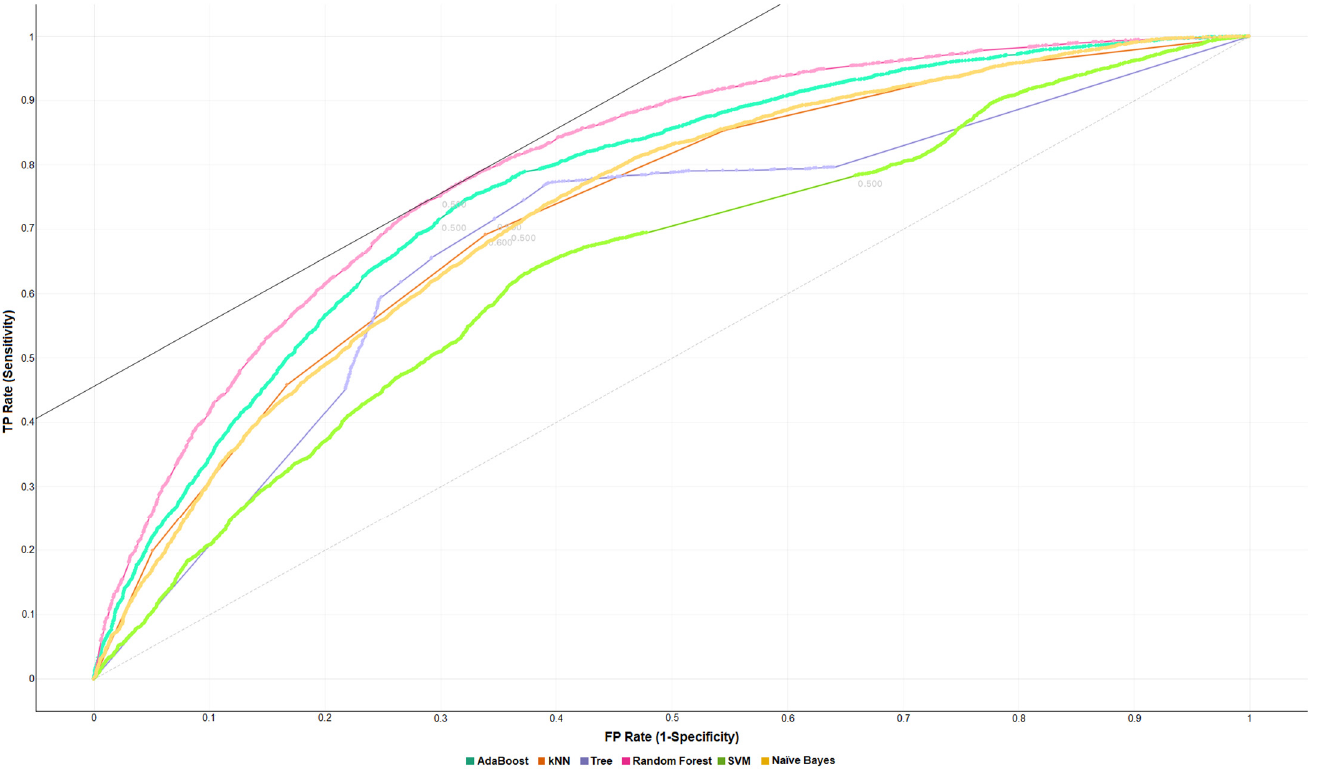
Figure 4. ROC curve for target = 1 with FP = 500, FN = 500, and target probability = 50.0%. The graph shows the ROC curves created by the false positive and false negative values with 10-folds stratified cross-validation. Each ROC curve is represented by a different color (See legend). The Random Forest algorithm shows the best value of AUC= 0.796 (See Supplementary Materials Table S2) for class 1 (records of schizophrenia).